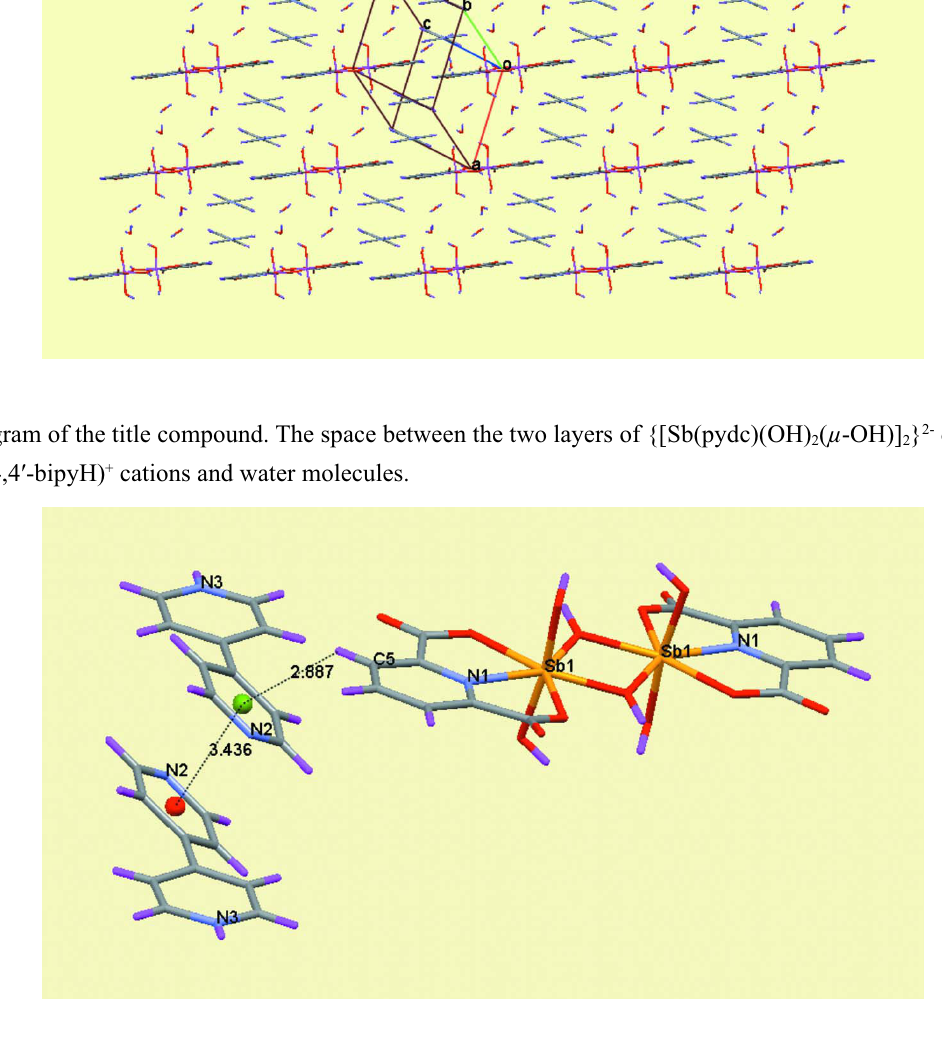
Figure 5 C—H··· π stacking interactions between the C–H group of the (pydc) 2– fragments and the aromatic rings of the (4,4′- bipyH) + units. The C—H··· π distance (measured to the center of phenyl ring) is 2.89 Å for C5—H5··· Cg 1 (1 - x , 1 - y , 1 - z ). π - π stacking interactions between the aromatic rings of the (4,4′-bipyH) + fragments with distance of 3.436 (2) Å